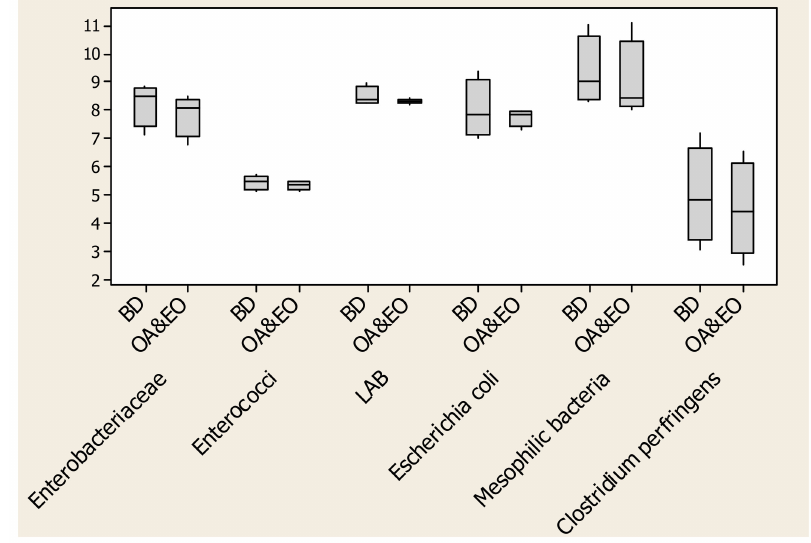
Figure 3. Boxplot of bacterial counts in caeca a ff ected by dietary treatments. Table 6. Bacterial count of litter as a ff ected by dietary treatment and sampling time (n = 1 for treatment at day 0; n = 3 for treatment at day 20 and at day